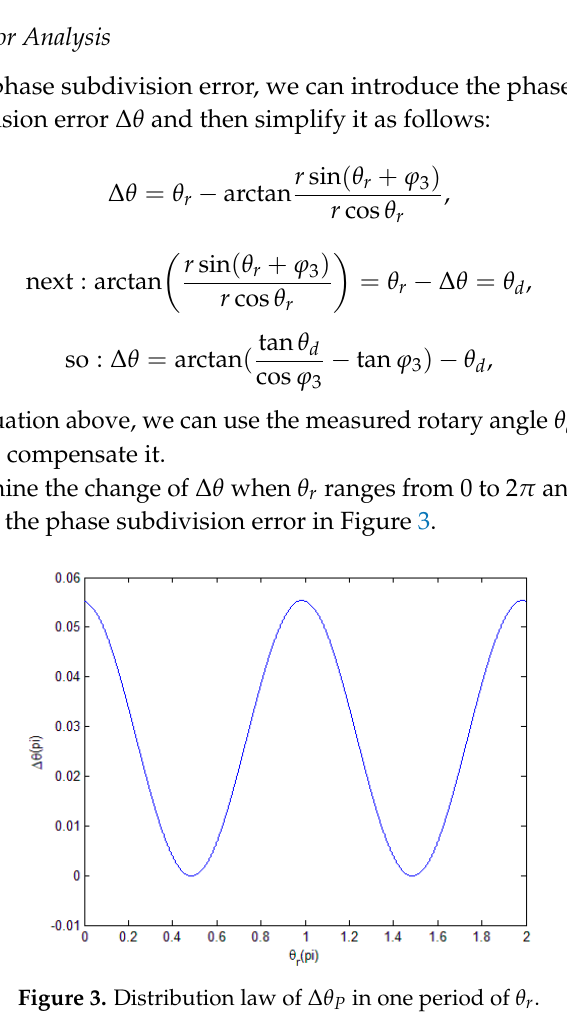
Figure 3. Distribution law of P